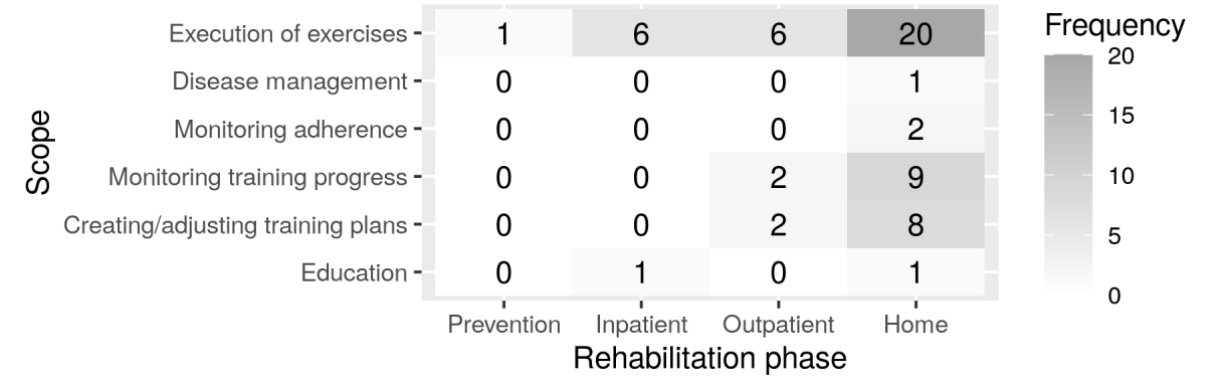
Figure 2. Heatmap of frequencies of scopes in individual rehabilitation phases; outpatient and inpatient refer to a rehabilitation facility (multiple mentions are possible in both